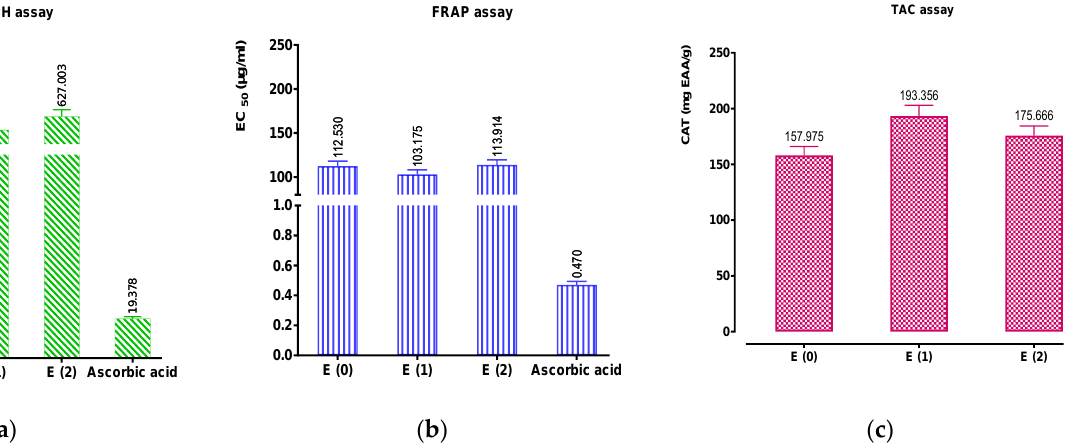
Figure 6. Antioxidant activity of ascorbic acid and extracts by: ( a ) DPPH; ( b ) FRAP; ( c ) TAC assays. Mean values ± standard deviations of determinations performed in triplicate are reported. Means are significantly different ( p < 0.001).